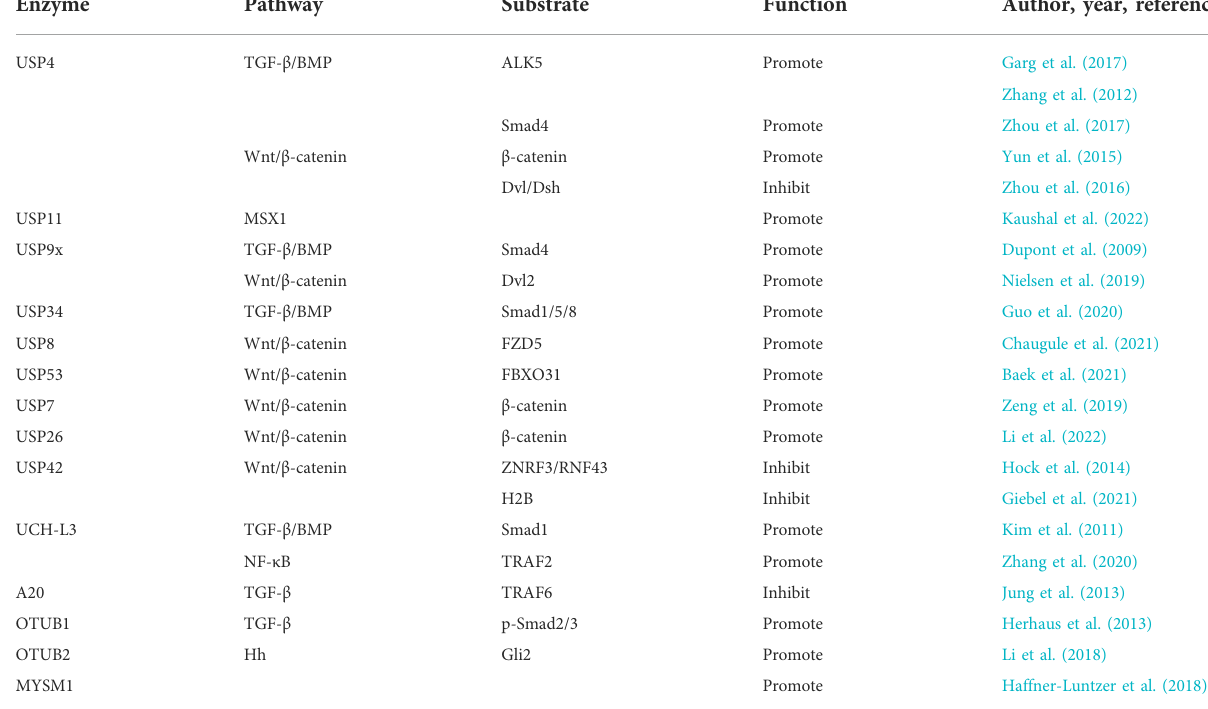
TABLE 3 The mechanism and effect of DUBs on osteogenic differentiation of MSCs. Enzyme